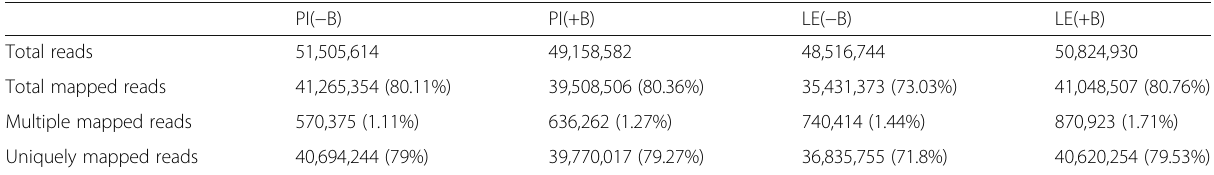
Table 2 Analysis of RNA-Seq data from rice